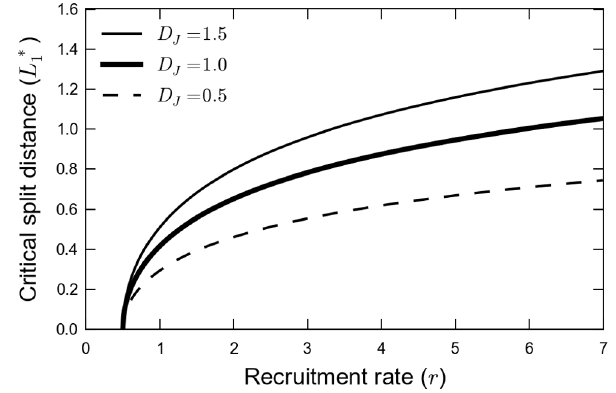
Figure 4. Critical split distance as a function of life history traits. The model explores two factors that modulate the habitat split effect: the recruitment rate and the diffusion coefficient of the juveniles. The parameters used were r ~ K ~ m J ~ D A ~ 1 , b ~ 0 and m A ~ 0 : 01 .